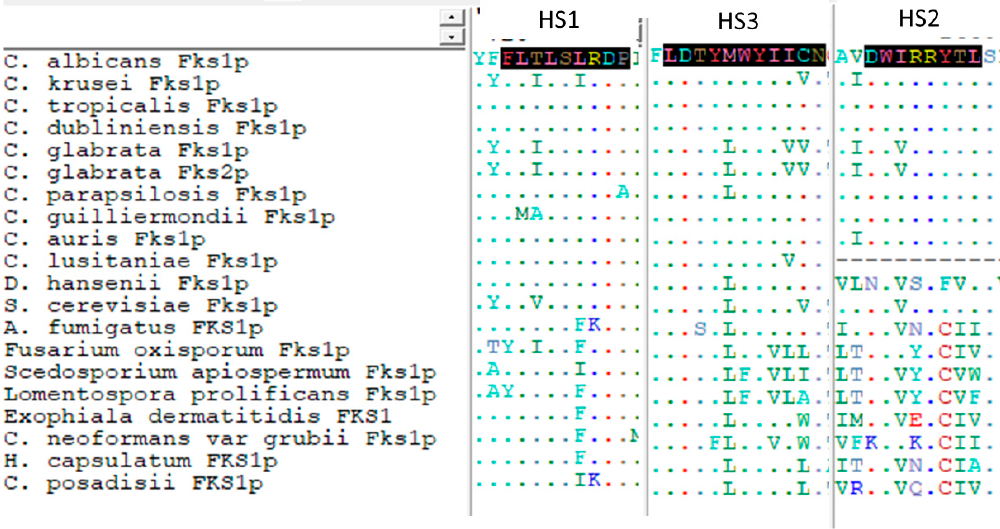
Figure 4. Clustal alignment of Fksps of different fungal pathogens. HS1: hot spot 1 region; HS2: hot spot 2 region; HS3: hot spot 3 region. Dots represent the same amino acid as C. albicans in its equivalent position.